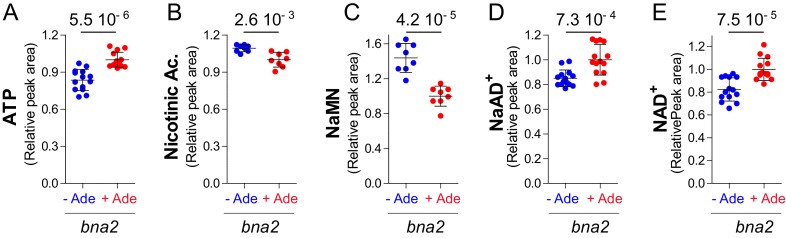
Modulation of adenine on NAD+biosynthesis operates in the absence of a functional de novo pathway.Pyridine salvage intermediate levels were determined in a bna2 mutant strain (Y11838) exponentially grown for 24 hr in SDcasaWU medium lacking (blue dots) or not (red dots) adenine. Values obtained in the presence of adenine (red dots) were set at 1. Quantifications were determined from independent metabolite extractions (N ≥ 8). Standard deviation is presented and indicated p-values were calculated using a Welch’s t-test.10.7554/eLife.43808.056Figure 8—figure supplement 1—source data 1.Pyridine pathway intermediates determination for the bna2 mutant strain ±adenine.